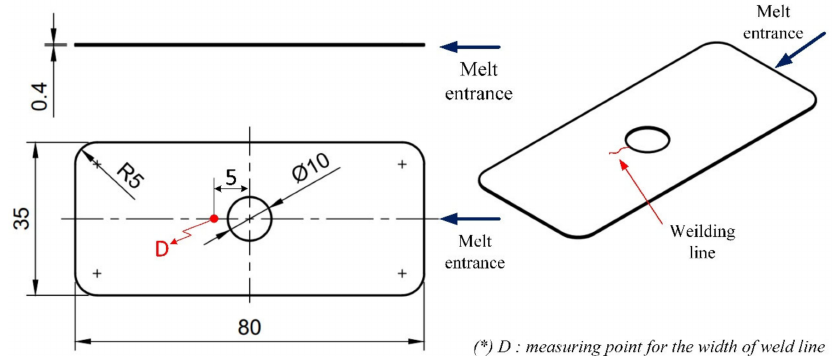
Figure 2. Schematic of the Ex-GMTC system.